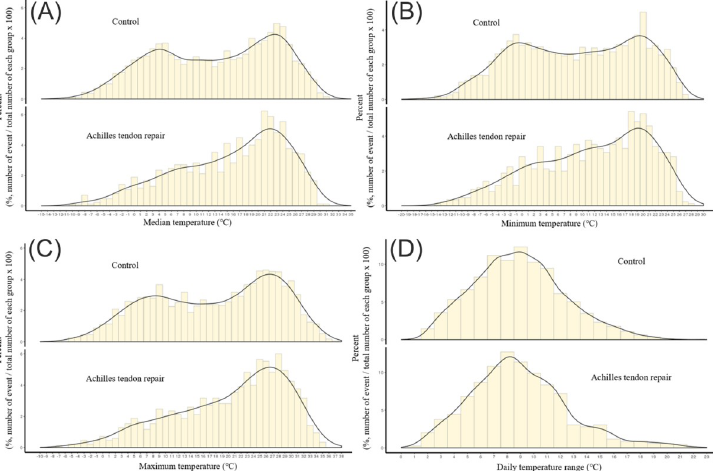
Fig 2. Distribution of temperature index in control group and achilles tendon repair group (2002–2015). (A-C) significant upward shifts in distributions of (A) median, (B) minimum, and (C) maximum temperatures of ATR group, compared with controls; (D) no significant difference in daily temperature ranges of ATR and control